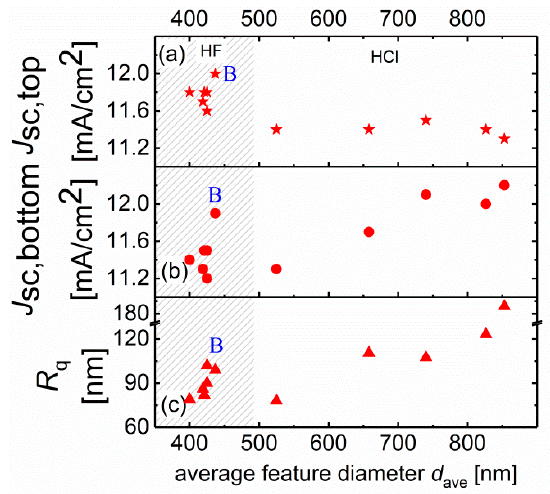
Figure 2. Short-circuit current density calculated from external quantum efficiency measurements of ( a ) top cell Jsc, top, ( b ) bottom cell Jsc, bottom, and ( c ) rms-roughness Rq as a function of the average feature diameter of textured ZnO:Al surface for test series 1. The sample ‘B’ is further discussed in Section 3.2.